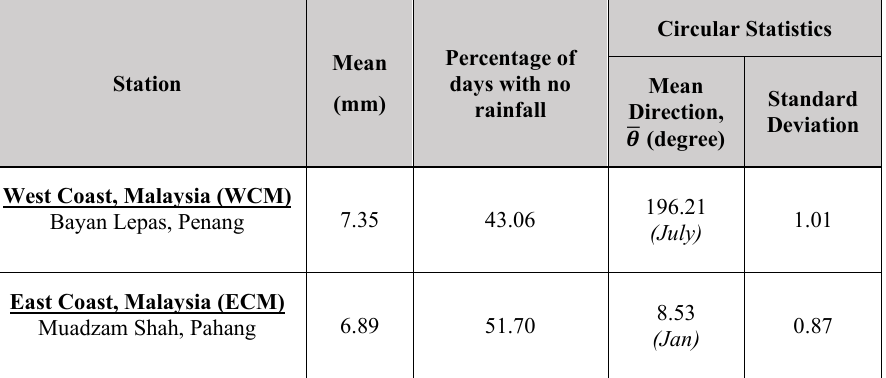
Table 1. Descriptive statistics of the daily rainfall for Bayan Lepas and Muadzam Shah stations. Station West Coast, Malaysia